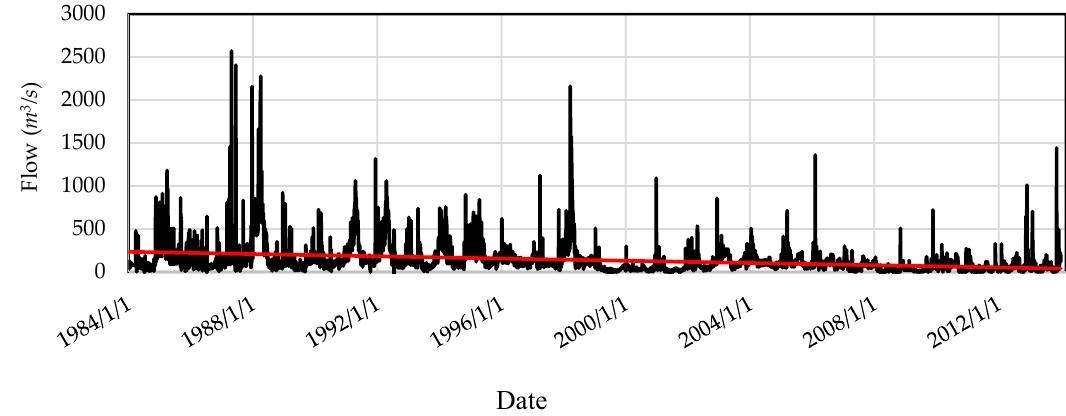
Figure 10. Temporal distribution of the streamflow of the Hemrin Watershed for the period from 1984 to 2013.